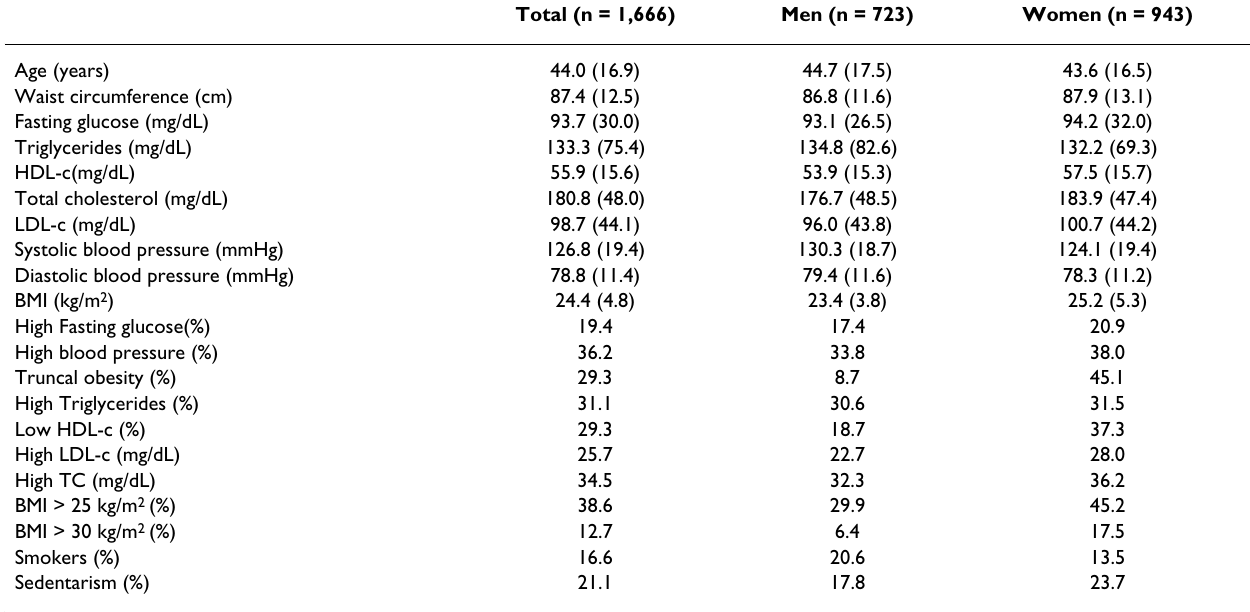
Table 1: Descriptive statistics of studied phenotypes, distributed by